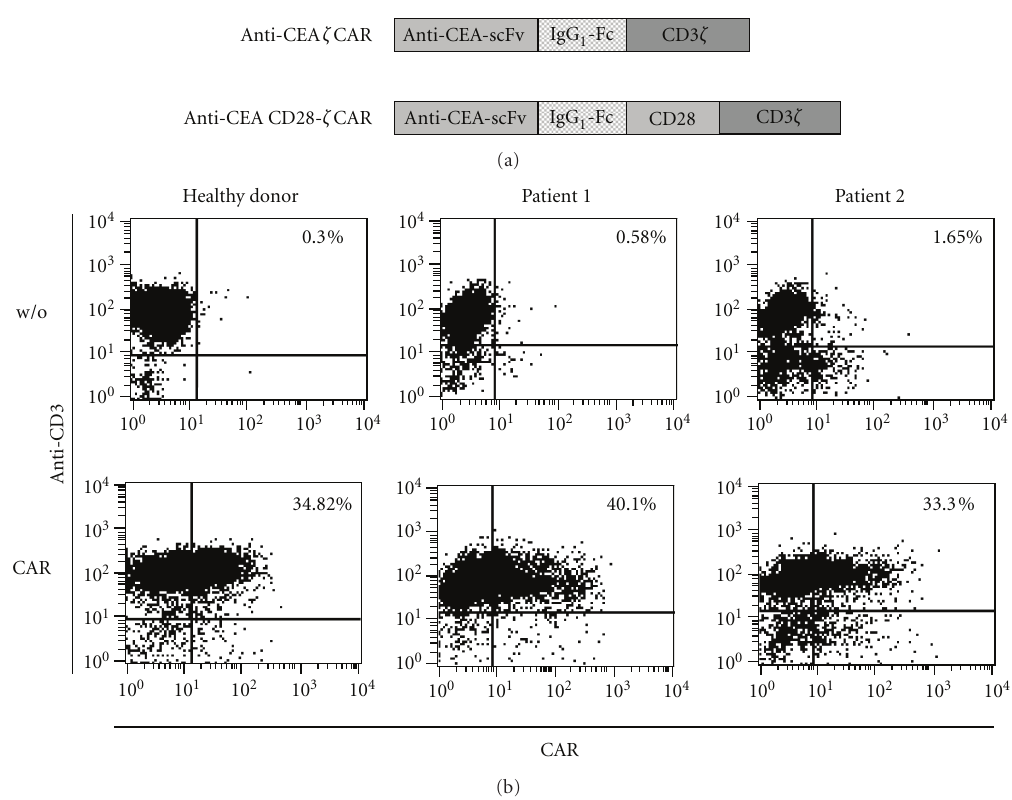
Figure 2: Genetic engineering of CIK cells with CARs. (a) Schematic diagram of the expression cassettes coding for the CEA-specific CAR BW431/26scFv-Fc-CD3 ζ and BW431/26scFv-Fc-CD28-CD3 ζ used in this study. (b) CIK cells were generated from mononuclear cells and subsequently transduced by retroviral infection to express the anti-CEA CAR. Mock-transduced cells (w/o) served as controls. CAR expression was recorded by flow cytometry using the anti-CD3 antibody OKT3 and the anti-human IgG-Fc antibody which detects the CAR extracellular IgG1 Fc spacer